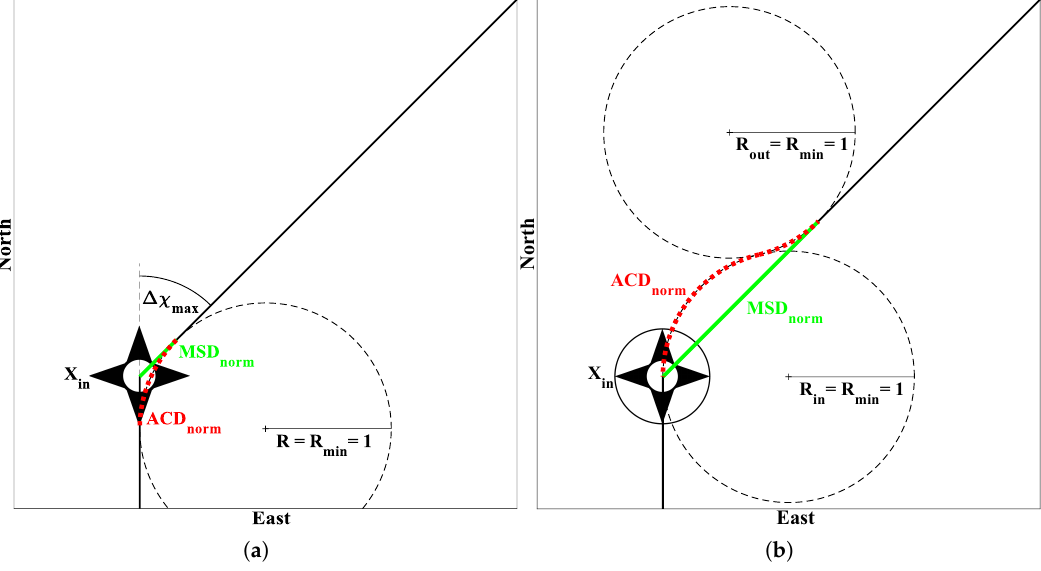
Figure 7. Normalized aircraft covered distance and normalized minimum stabilization distance, when x in is performed ( a ) as fly-by or ( b ) as fly-over